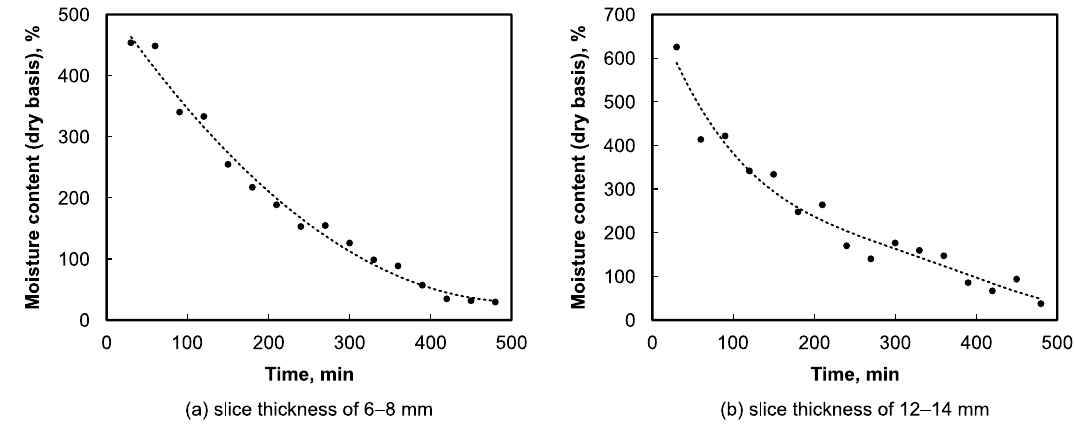
Figure 9. Drying kinetics of pineapple slices with the thickness of ( a ) 6–8 mm and ( b ) 12–14 mm.